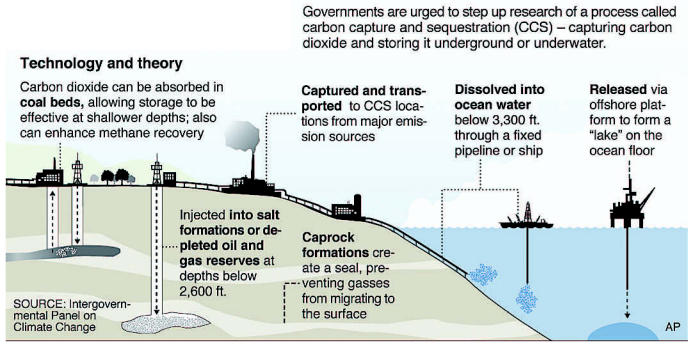
Capturing carbon